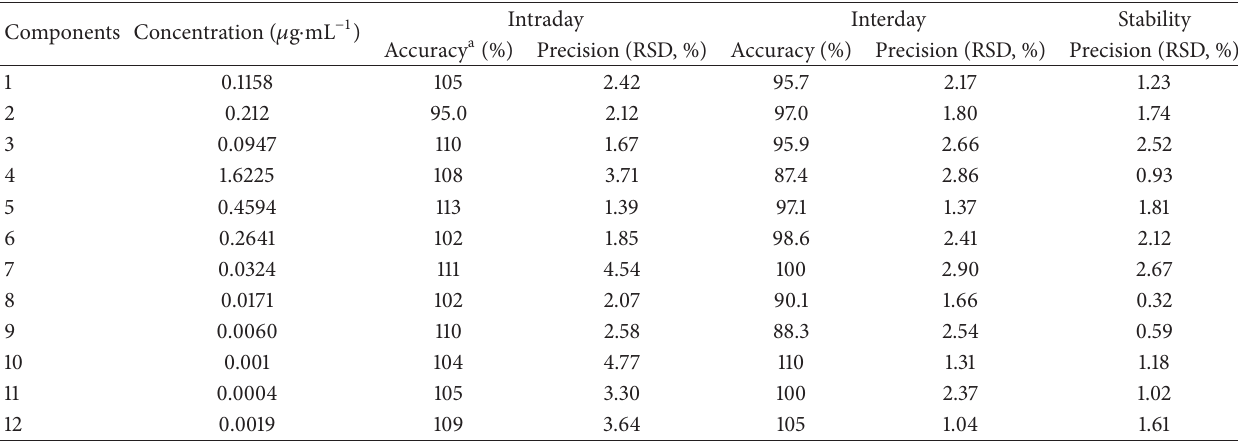
Table 2: Intra- and interday accuracy, precision, and stability for the twelve